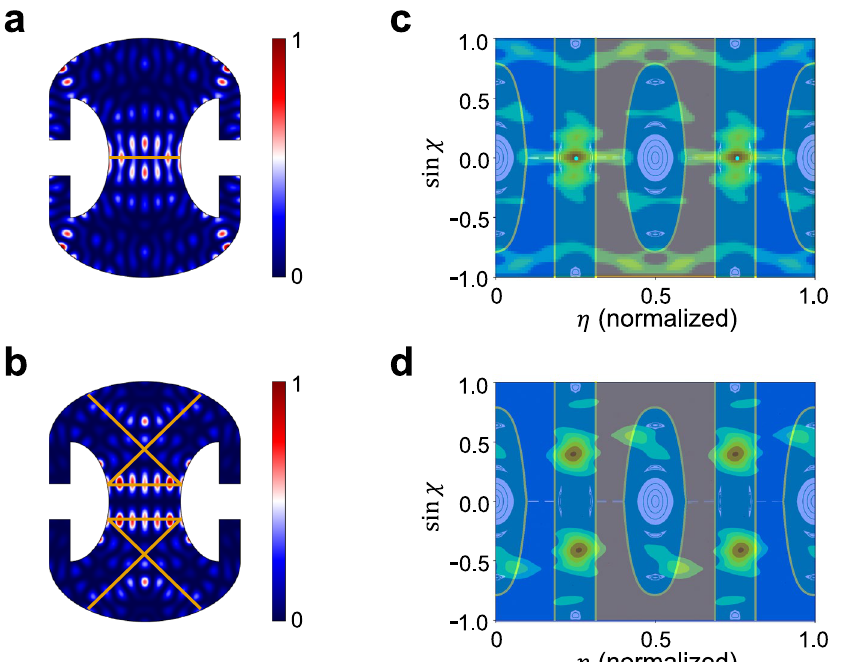
Figure 4. Scarred and quasi-scarred modes contributing to the HIM. ( a ) The intensity distribution of mode b (a scarred mode) and ( b ) that of mode c (a quasi-scarred mode), as labeled in Fig. 3b, and their corresponding ray trajectories (orange solid lines), respectively. ( c ) Husimi distribution of mode b overlapped on the PSOS. ( d ) The same for mode c. The scarred mode in ( a ) can be associated with an unstable periodic orbit [marked by cyan-colored points in ( c )]. The quasi-scarred mode in ( b ) has no corresponding periodic